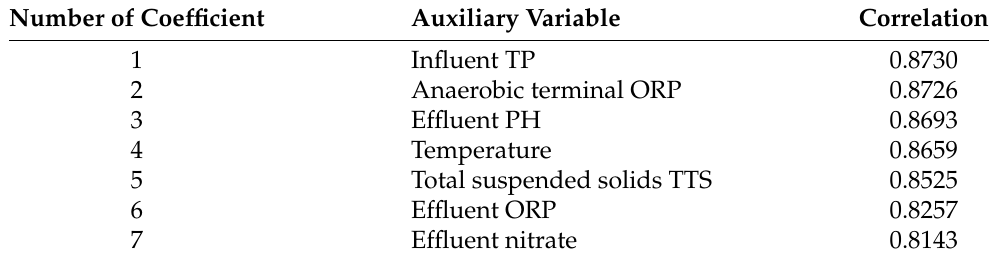
Table 8. Data after processing.